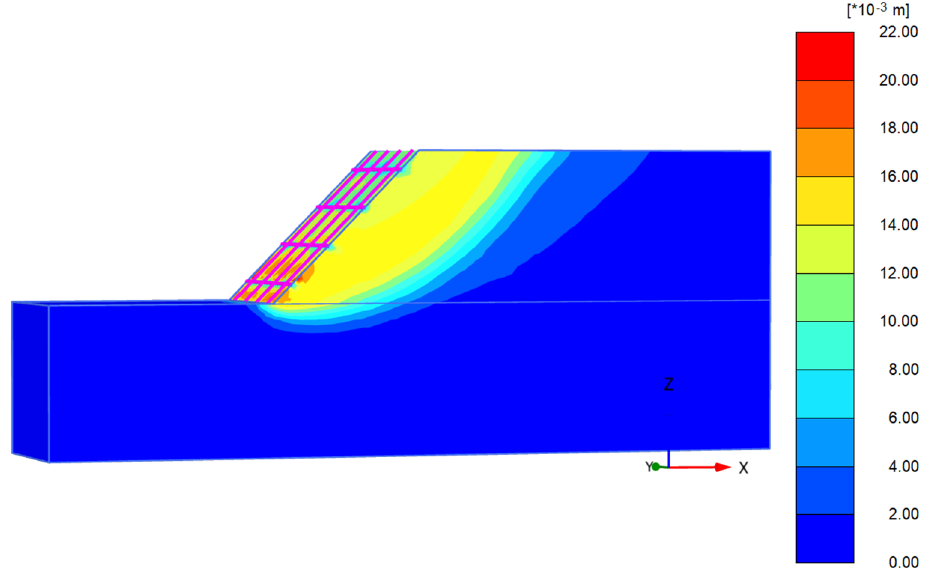
Figure 24. Total displacement increment cloud map of 1:1 model.